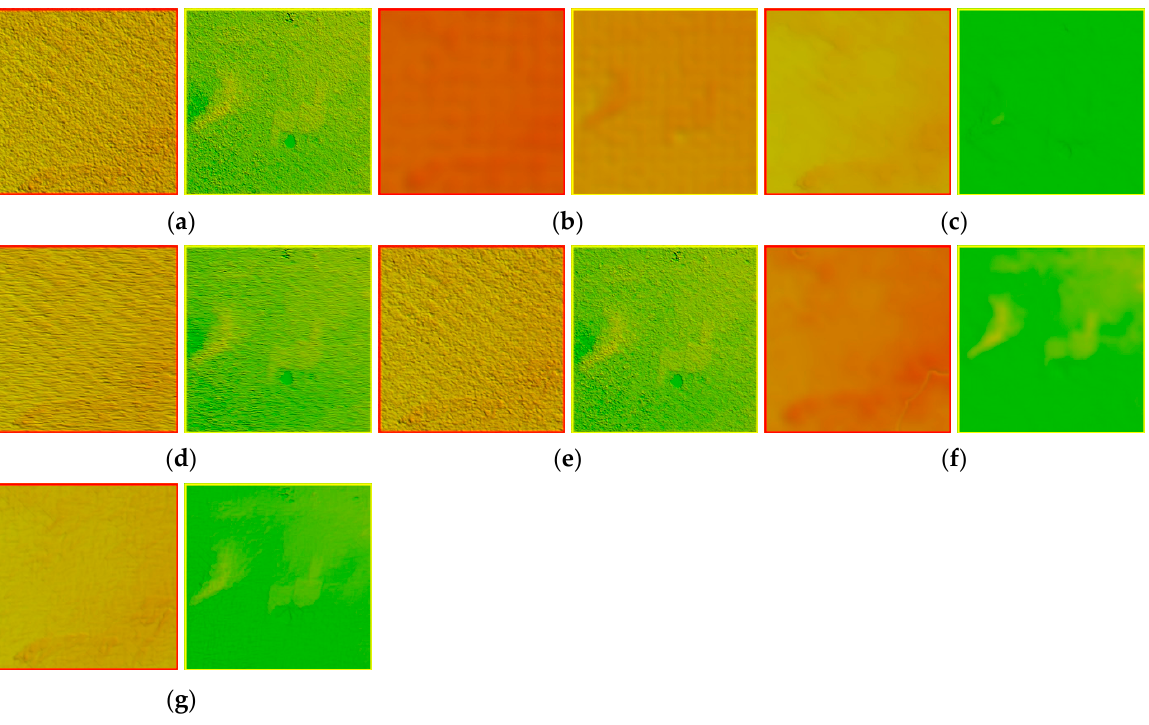
Figure 12. Results of the real experiment for area S35E144 (unit: meter). ( a ) Original area S35E144, ( b ) low-pass filter, ( c ) TV, ( d ) UTV, ( e ) LRSID, ( f ) Gallant and ( g ) LRGS.